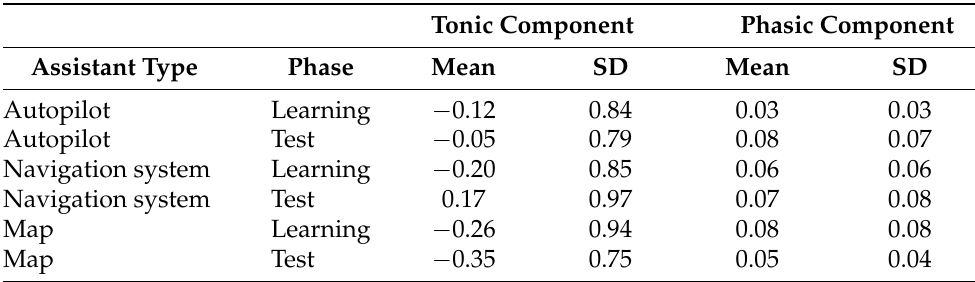
Table 3. Descriptive statistics for the tonic and phasic components by the assistant type and driving phase. All values are Z-score